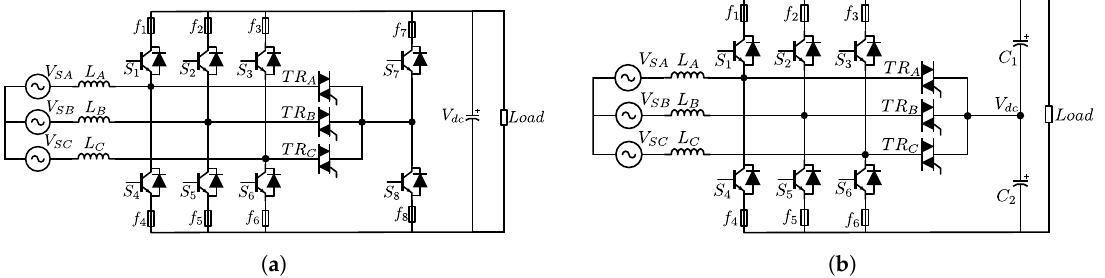
Figure 9. Fault-tolerant topologies. ( a ) PEC for PMSG turbine. The four-leg converter can isolate the faulty leg using the fourth auxiliary leg. ( b ) PEC for PMSG turbine. The respective faulty-phase TRIAC TR A , TR B , or TR C is connected to the DC split bus to isolate the